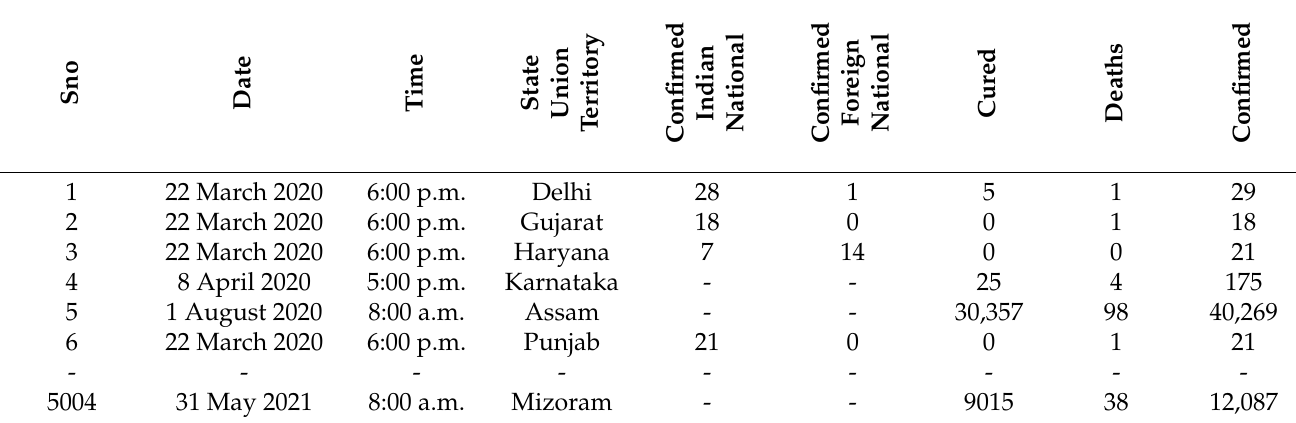
Table 2. Sample instances of the COVID-19